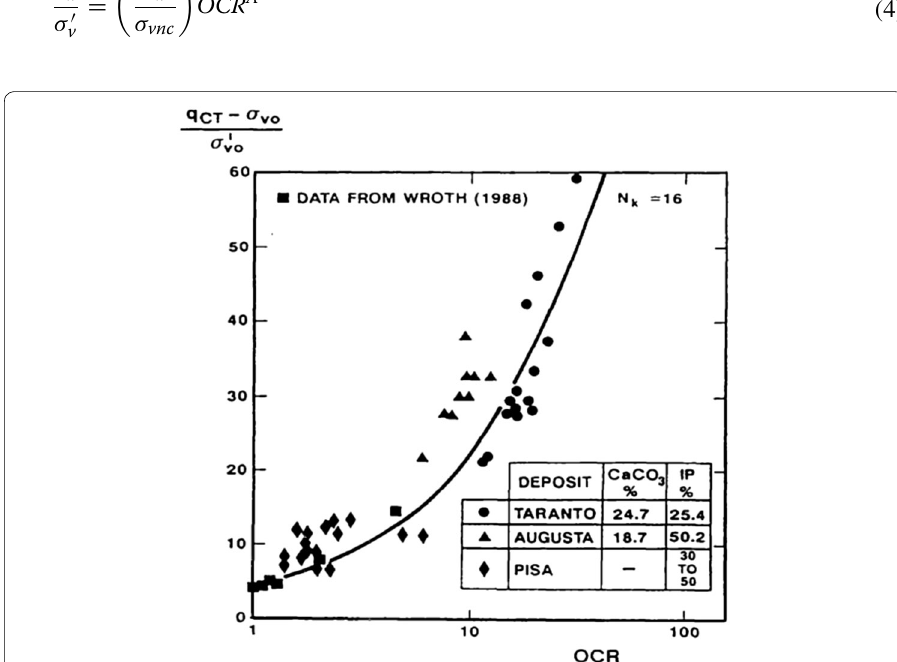
Fig. 1 Estimation of OCR from normalized net cone resistance (after